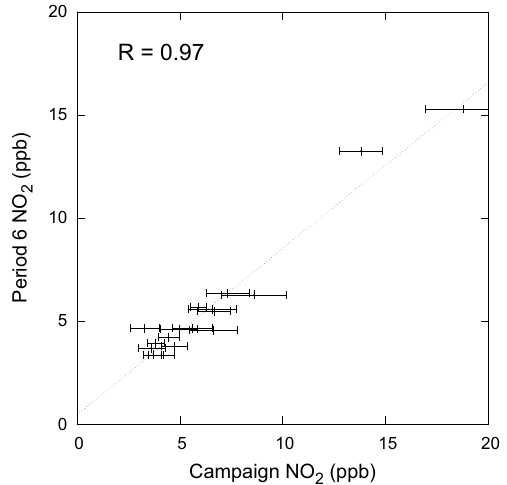
Fig. 3. NO 2 measured at 1 urban (Windsor) and 2 rural (Harrow, Bear Creek) locations during 1 week of the BAQS-met 2007 cam- paign. This week was selected as generally representative of pat- terns observed over the whole campaign. NO 2 concentrations can be seen to exhibit significant diurnal and day-to-day variation.